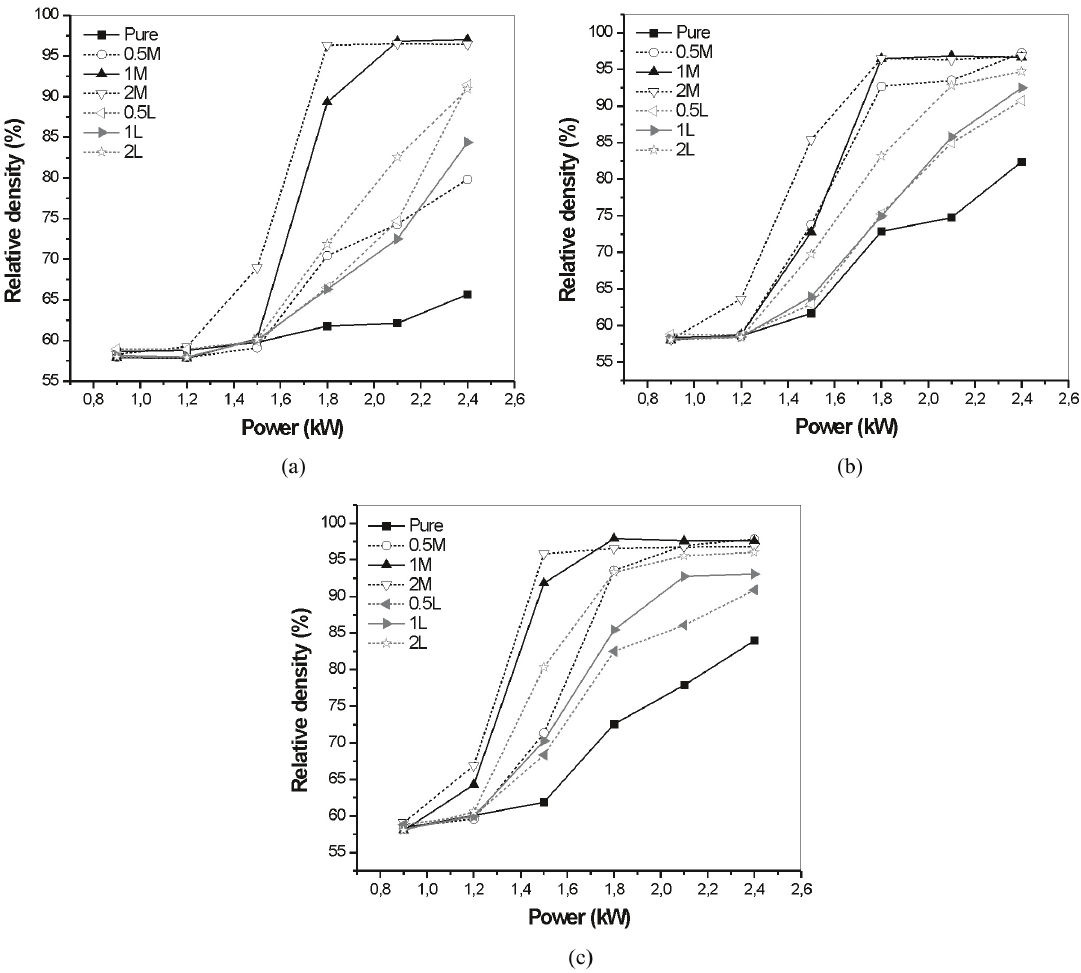
Figure 3. Relative density of samples microwave-sintered for: a) 20min, b) 30min and c) 40min.